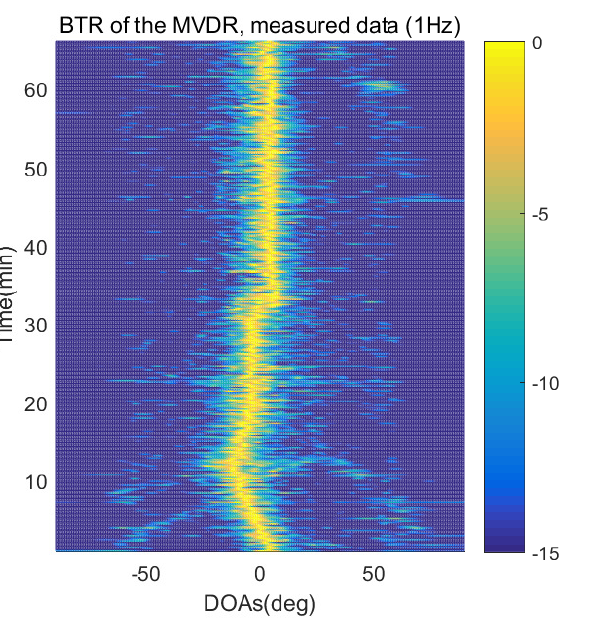
Figure 15. Bearing time records of the MVDR: 66 min, pilot signal frequency = 1